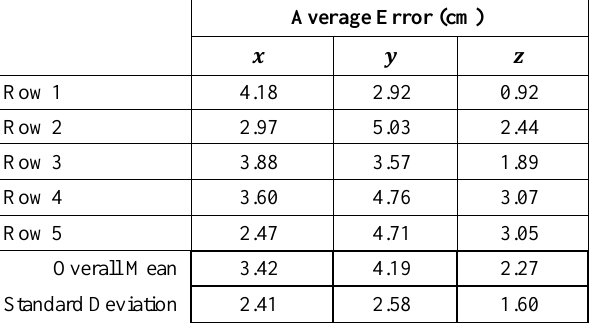
Table 1: Average error in estimating the 𝒙 , 𝒚 and 𝒛 coordinates of the hand-mounted mobile tag for each row of the matrix locations. Average Error (cm) 𝒙 𝒚 Row